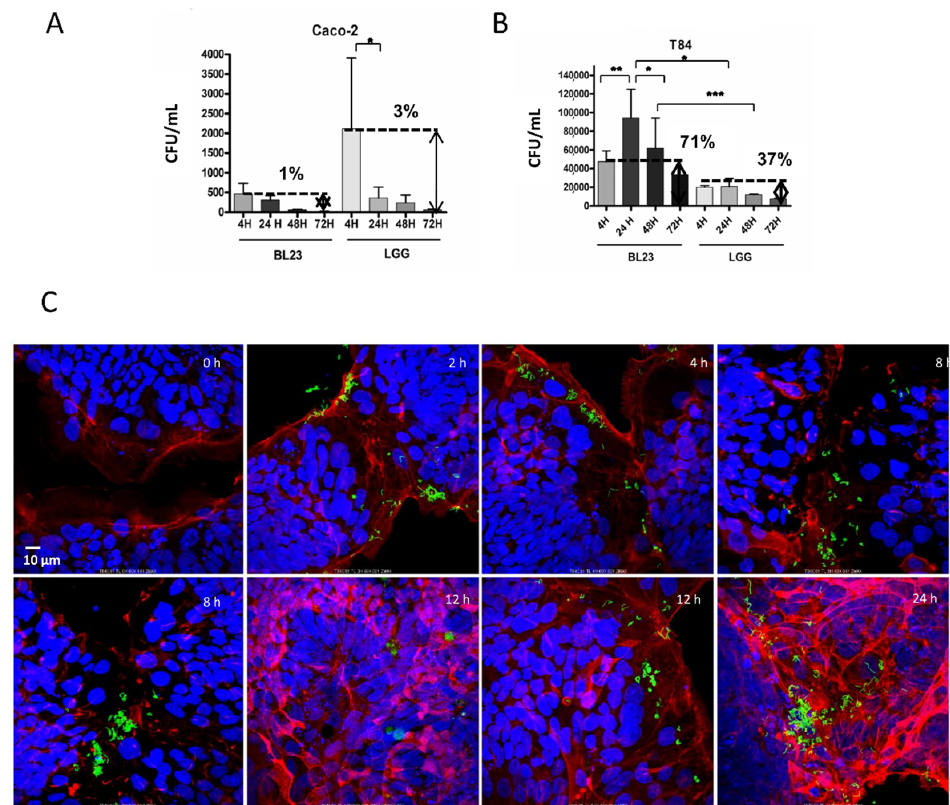
Figure 5. Survival of BL23 and LGG in the cytoplasm of T84 and Caco-2 at different times (4 h to 3 days). Gentamicin internalization. ( A ) Number of cfu/mL after incubation of BL23 and LGG with Caco-2 for the times indicated (4, 24, 48 and 72 h). ( B ) The same as in A, but in T84. ( C ) Confocal microscopy image of the internalization process of BL23 [pT1-GR::p127] by T84 after 2 h of co-incubation with bacteria and extended for 24 h with gentamicin. The experiments were performed with five replicates in triplicate and the differences between groups compared with the Bonferroni test. p -value ≤ 0.05 (*), p -value ≤ 0.001 (**), p -value ≤ 0.0001 (***). ( C ) Confocal microscopy image of the internalization process of BL23 [pT1-GR::p127] by T84 after 2 h of co-incubation with bacteria and extended for 22 h with gentamicin. Fluorophores legend: DAPI in blue, GFP in green, Actin in red. Objective used: 60×.